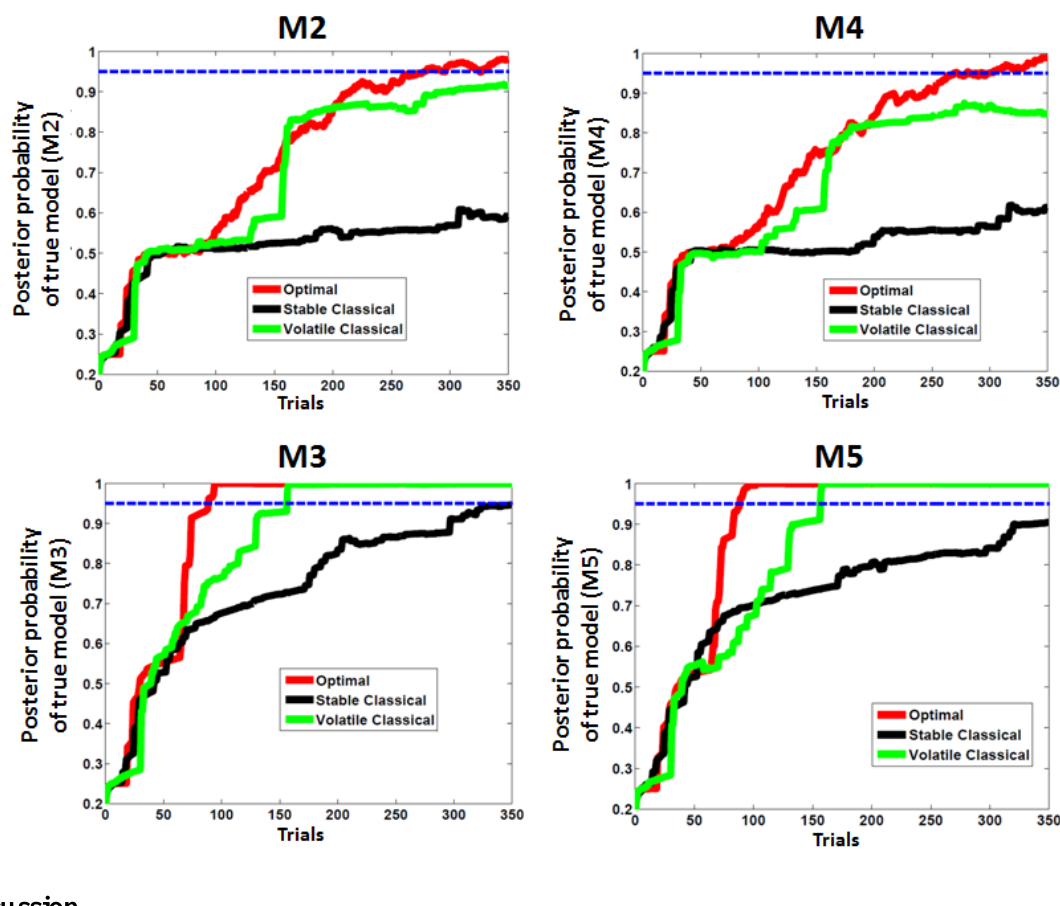
Figure 8. Posterior model probabilities at each trial in our simulated experiment: the average over 15 simulations for each